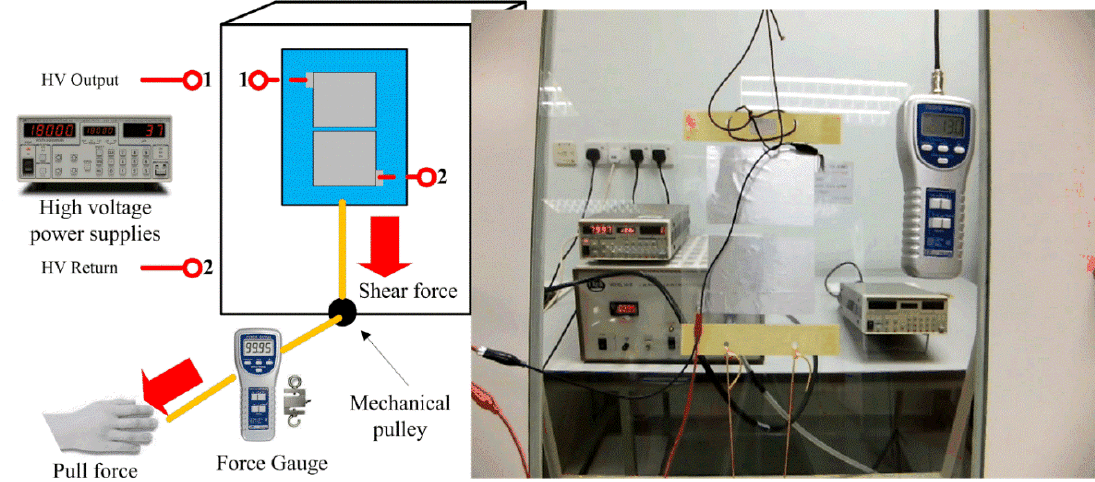
Figure 6. The experimental setup for shear force measurement (a supplemental video for the experiment is